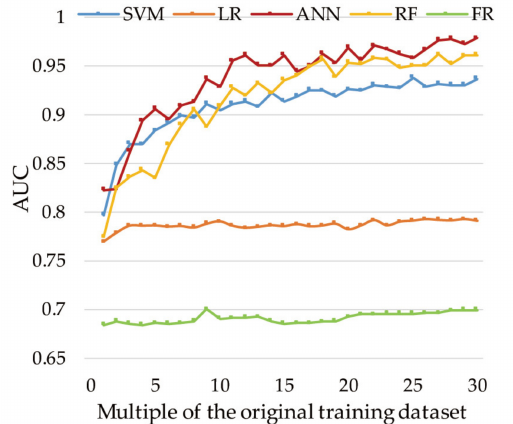
Figure 14. AUC of predictive performance for the RF model with different training